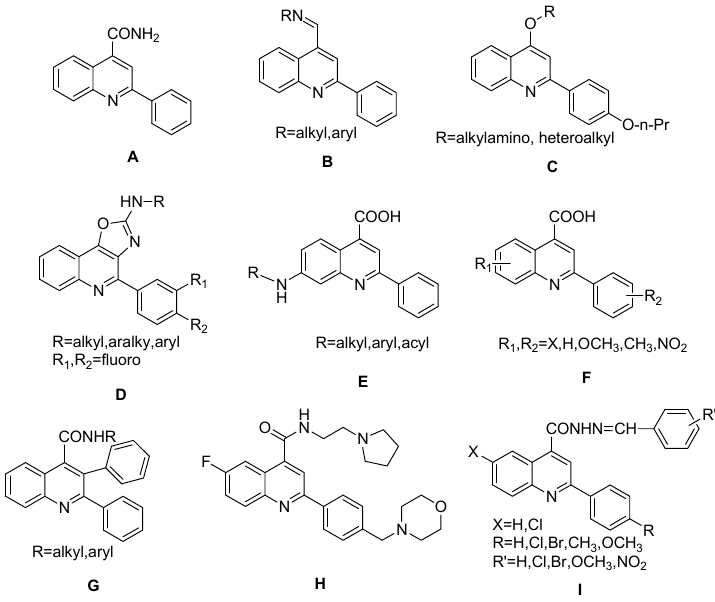
Figure 1. The structures of 2-aryl-quinoline-4-carboxylic acid derivatives with antimicrobial